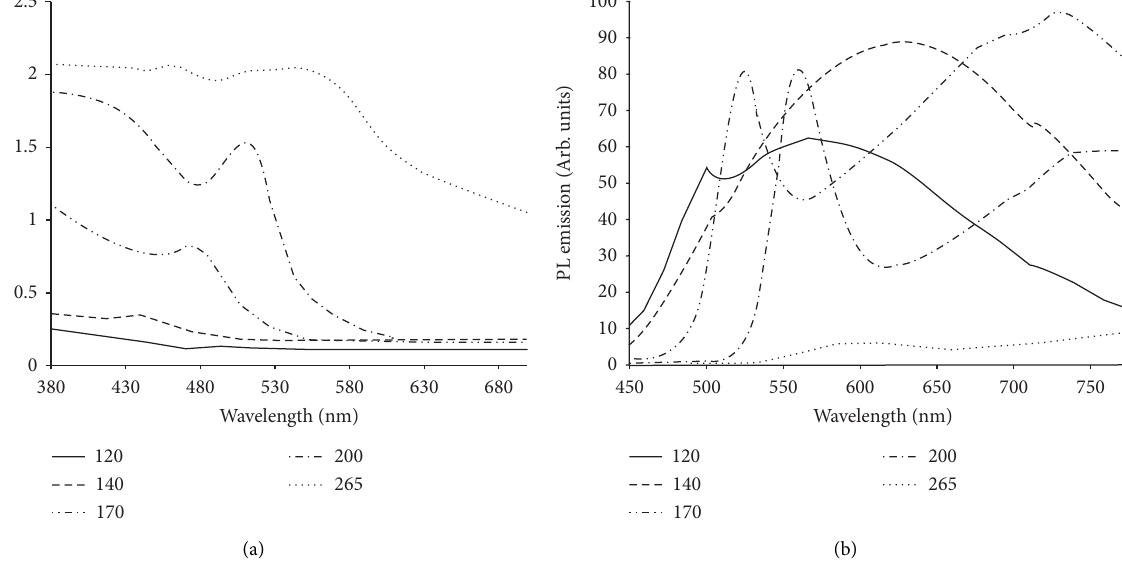
� 400nm) (b) of QDs synthesized via the microwave method. ex